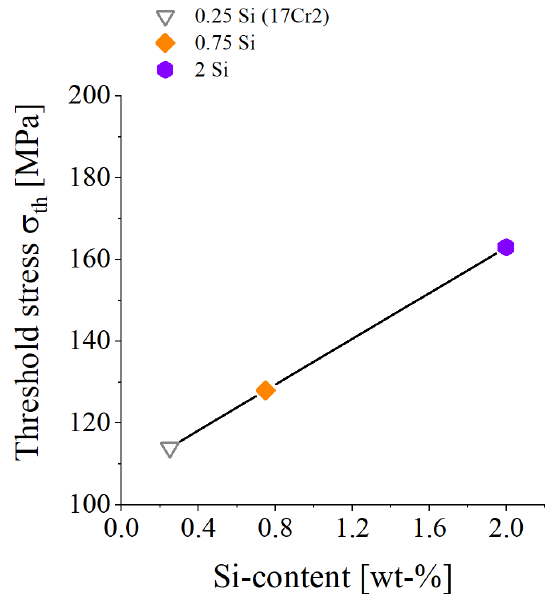
Figure 4. Effect of Si on σ th [54].